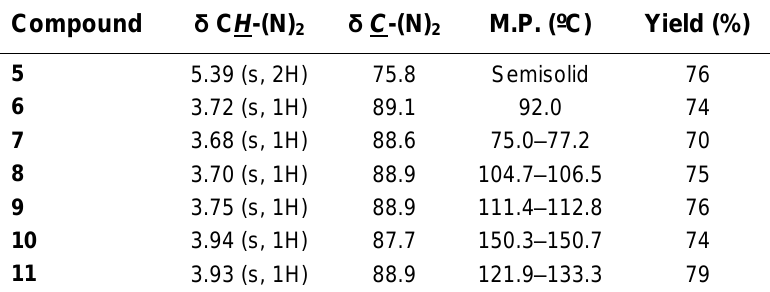
Spectral Dates of Imidazolidine